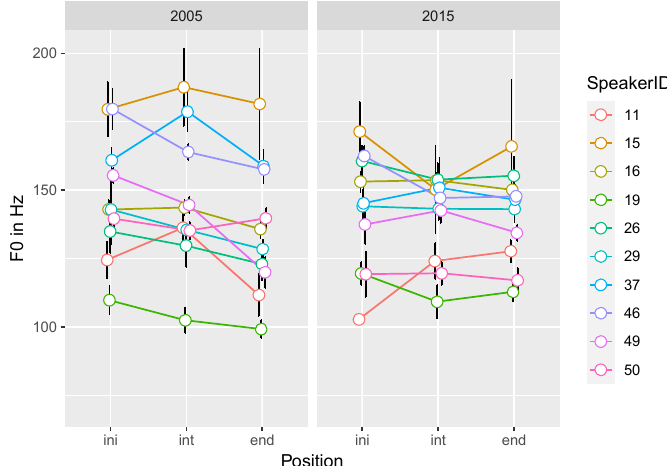
Figure A2. Speaker-specific data for F2.